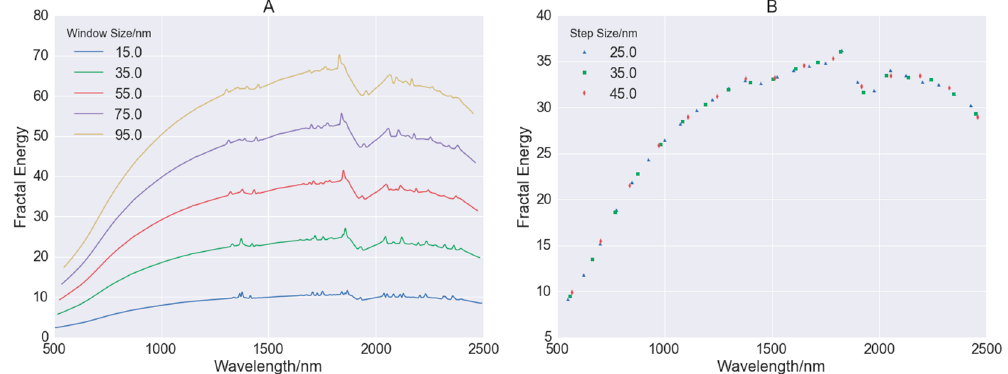
Figure 5. The effect of step and window size on generated fractal features. ( A )are fractal feature curves when window sizes were at 15.0–95.0 nm (step size fixed at 2.5 nm); ( B ) is the number of fractal features when step sizes were increased from 10.0 to 50.0 nm (window size fixed at 50.0 nm).